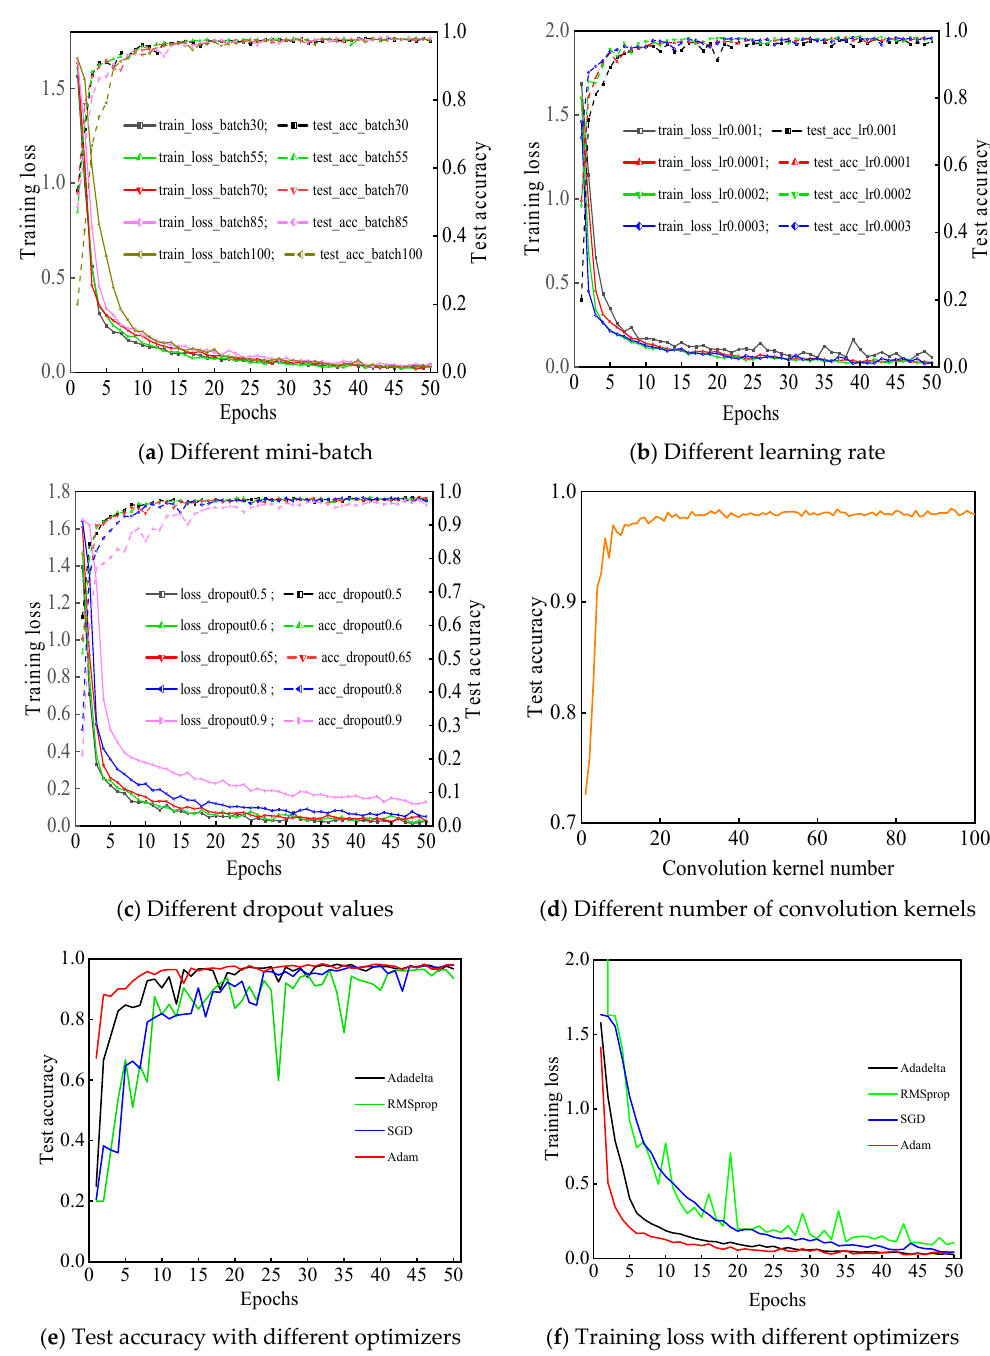
Figure 7. The tendency of different model parameters.